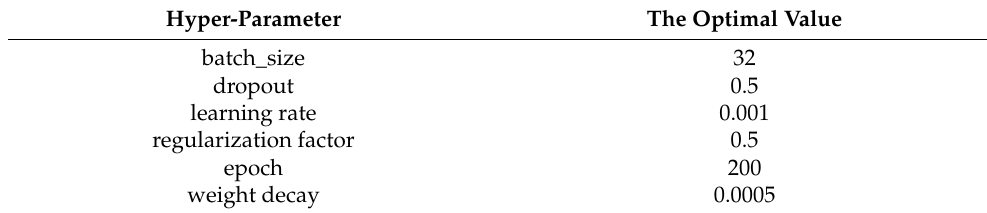
Table 2. Results of hyperparameter optimization.